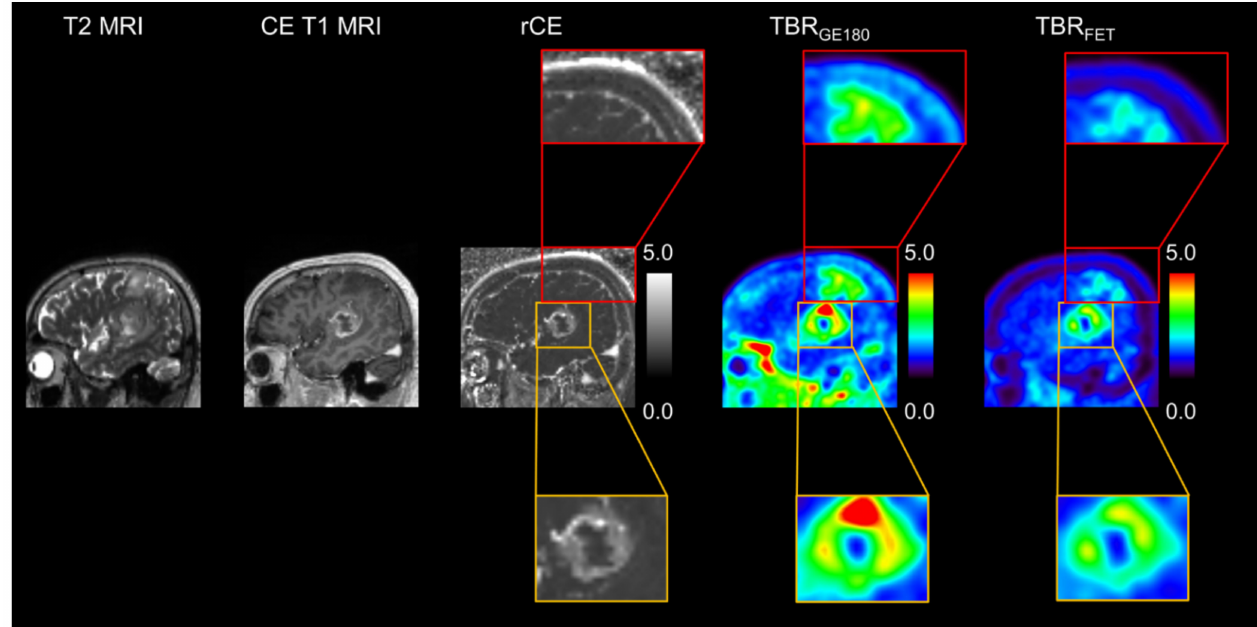
Figure 6. Shown are multi-modal images of one example patient in sagittal view. Depicted are T2- weighted (T2 MRI) and contrast enhanced T1-weighted MRI images (CE T1 MRI) and the generated relative contrast enhancement (rCE) and tumor-to-background ratio (TBR GE180 , and TBR FET ) images. Color-bars and intensity ranges are provided for quantitative images. The patient presented with clear tumor specific signal within each modality. In the superior part an additional tumor area without MRI contrast enhancement can be identified using PET, with [ 18 F]GE180 PET signal revealing the highest contrast to